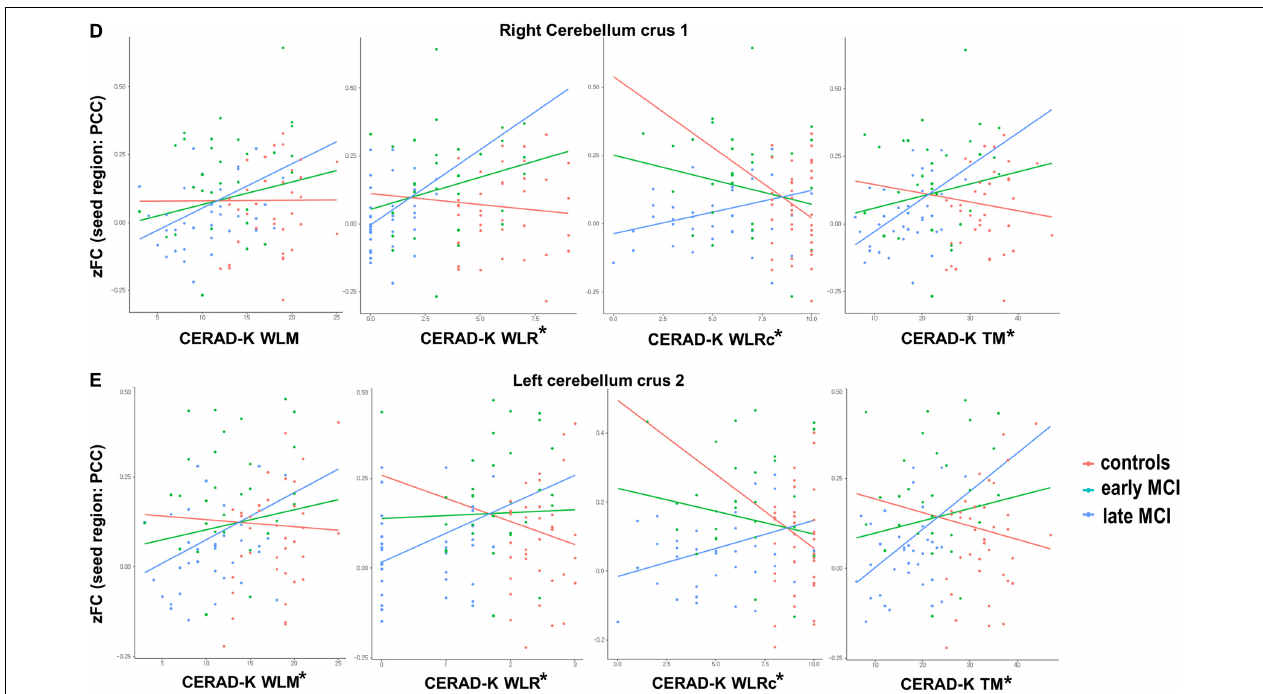
FIGURE 2 | Significant group [healthy control vs . early-mild cognitive impairment (MCI) vs . late MCI] by cognitive performance interactions for functional connectivity between posterior cingulate cortex and (A) right frontal lobe, (B) right superior temporal gyrus, (C) left cingulate gyrus—mid part, and (D,E) bilateral cerebellum. CERAD-K, Korean version of the Consortium to Establish a Registry for Alzheimer’s disease; VF, verbal fluency; BNT, Boston Naming Test; WLM, word list memory; WLR, word list recall; CR, constructional recall; TM, total scores of memory domains, including CERAD-K WLM, WLR, and WLRc; *Bonferroni-corrected P < 0.05 by multiple regression